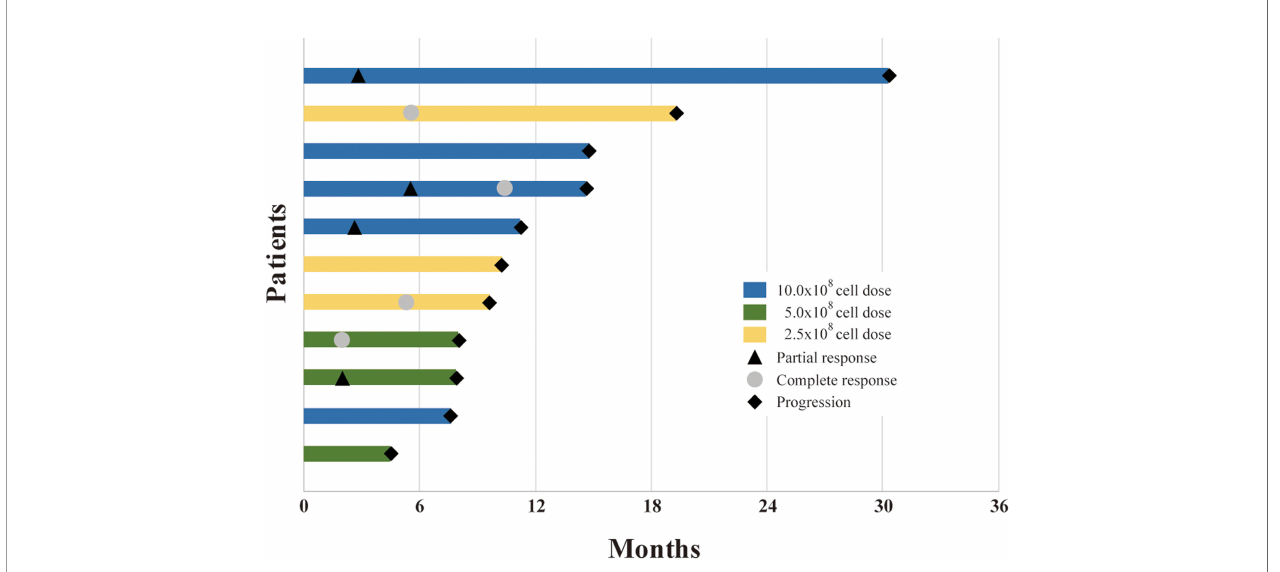
FIGURE 3 | Time to progression and duration of response in patients with an objective response.